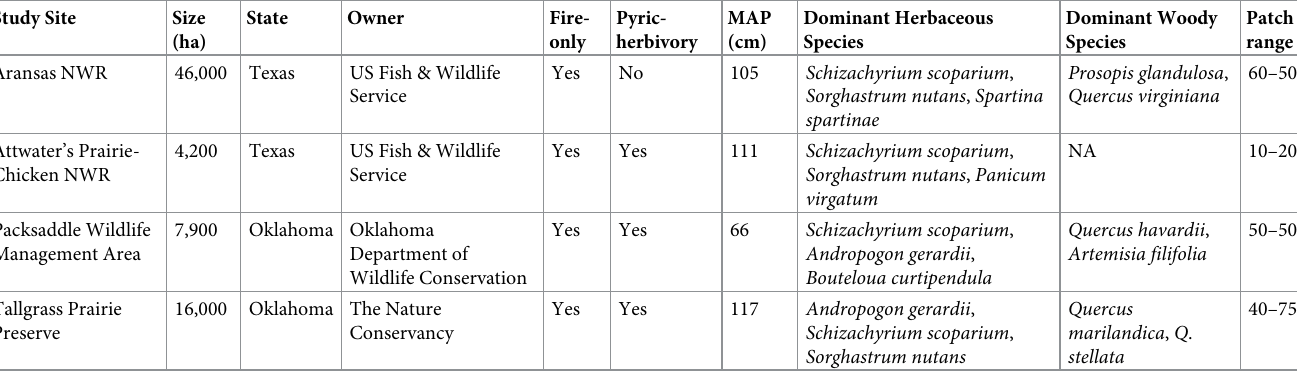
Table 2. Study sites and